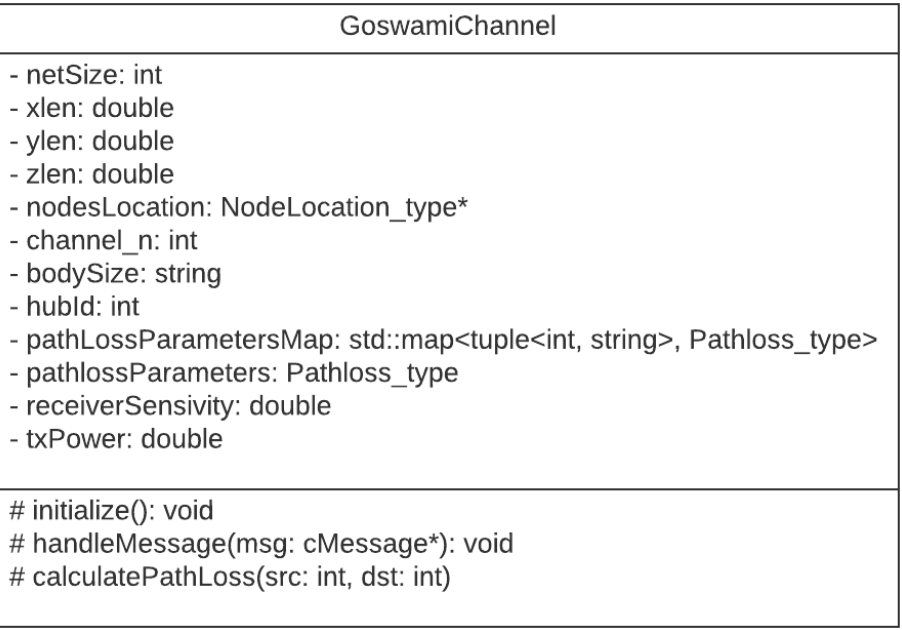
Figure 2. Goswami channel class implemented in the BNS framework. The character “*” refers to pointer-type